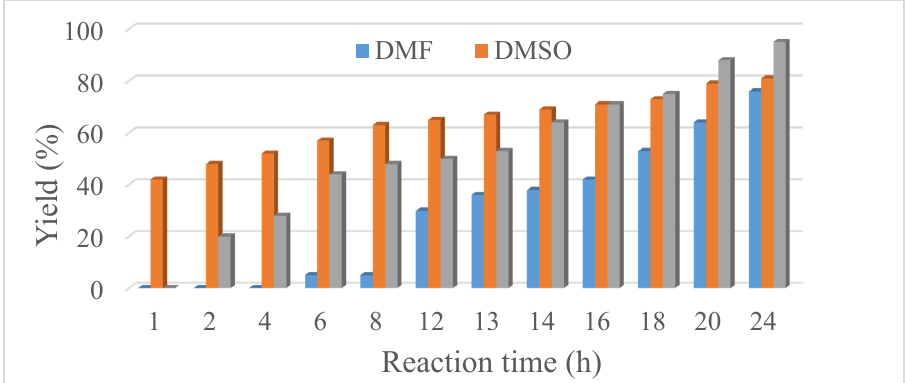
Figure 7. The biphenyl yield in the reaction of iodobenzene and phenylboronic acid in toluene after 24 h (blue) and in DMSO after 1 h (red) with the selected NiNPs samples at reflux temperature.